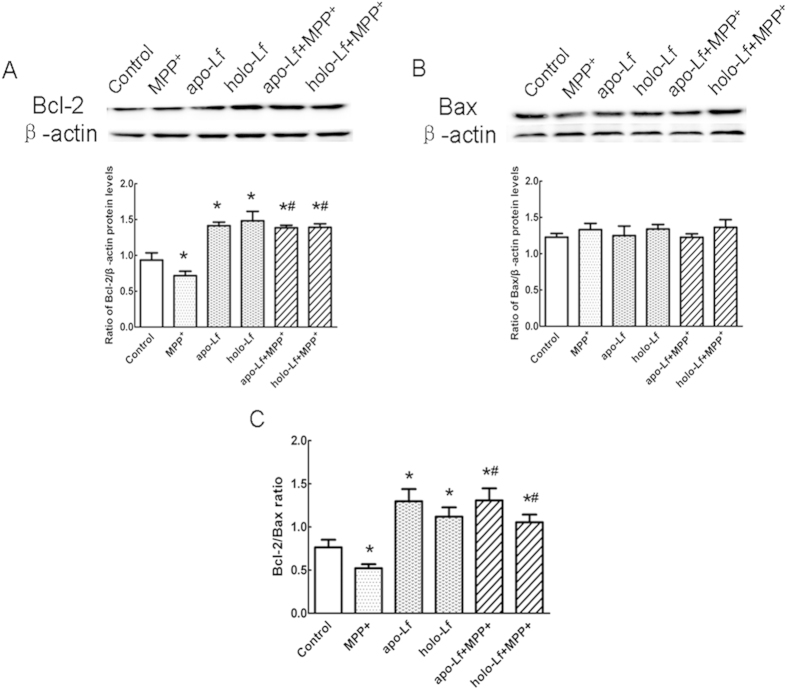
Bcl-2 and Bax protein levels in MPP+-treated VM neurons with apo-Lf or holo-Lf pretreatment.Western blots were applied to detect Bcl-2 and Bax protein levels. (A) Bcl-2 expression was decreased in MPP+-treated cells. Both apo-Lf and holo-Lf could elevate Bcl-2 expressions in VM neurons compared with control group. Apo-Lf or holo-Lf pretreatment increased the expression of Bcl-2 in MPP+-treated cells. (B) Bax protein levels had no change in different groups. (C) Effects of Lf on Bcl-2/Bax ratio in different groups. Bcl-2/Bax ratio significantly increased due to apo-Lf or holo-Lf treatment in VM neurons. And apo-Lf or holo-Lf pretreatment reversed the decrease of Bcl-2/Bax ratio in MPP+ treated group. β-actin was used as a loading control. Data were presented as the ratio of Bcl-2 or Bax to β-actin. Each bar represented the mean ± S.E.M. *P < 0.05, compared with the control; #P < 0.05, compared with MPP+ group; n = 4.